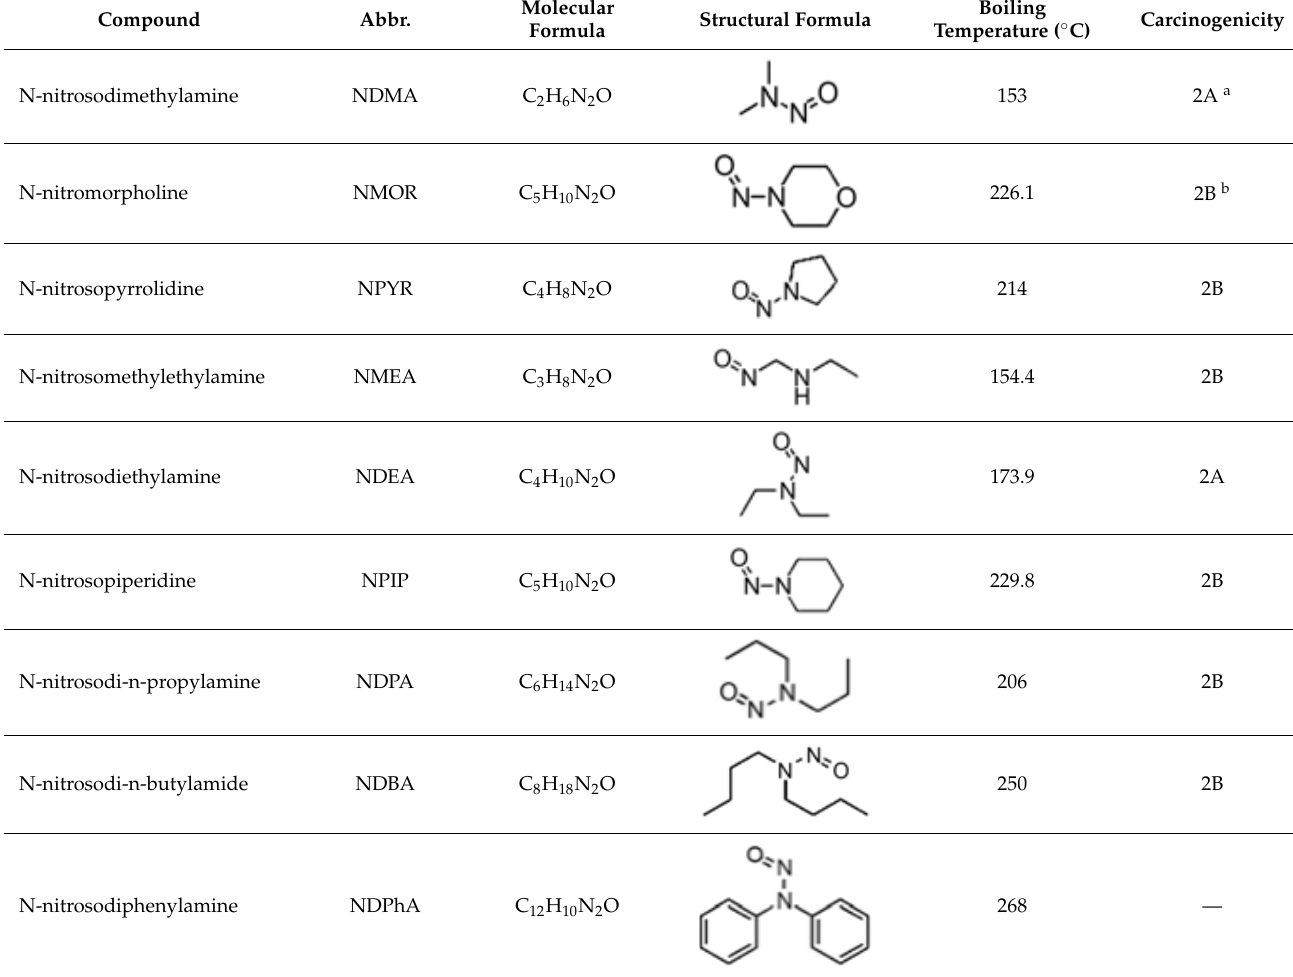
Table 1. Physicochemical properties of common N-nitrosamines. Molecular Structural Compound Abbr. Formula